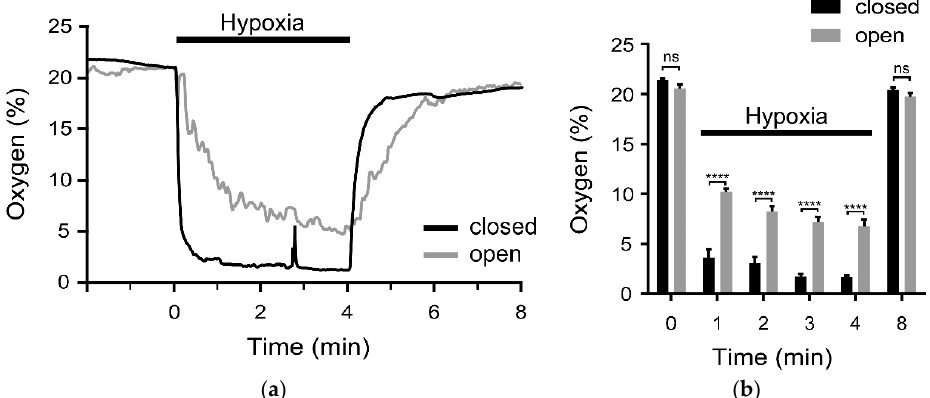
Figure 4. ( a ) Oxygen content inside the open (grey trace) and the closed, microfluidic system